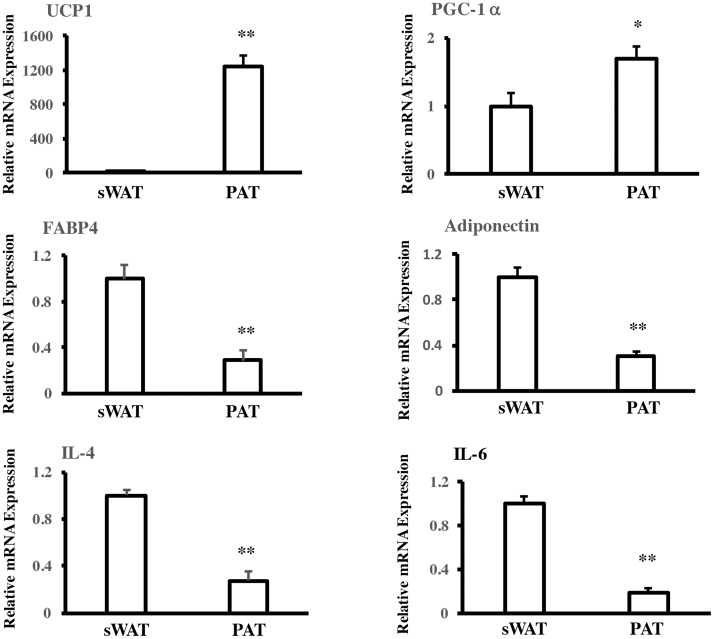
Adipokine and thermogenic mRNA expression in subcutaneous adipose tissue (sWAT) and periaortic adipose tissue (PAT).Quantitative PCR analysis of sWAT and PAT samples showing the expression of some thermogenic, adipokine and inmmune genes. UCP-1, Uncoupling protein 1; PGC-1a, PPARg coactivator 1 alpha; FABP4, fatty acid binding protein 4; IL-4, Interleukin 4; IL-6, Interleukin 6. Quantitative PCR analysis showing the expression of * p<0.05 and ** p<0.01 (n = 8) indicate a statistically significant difference between gene expression levels in sWAT and PAT (mean ± SD).